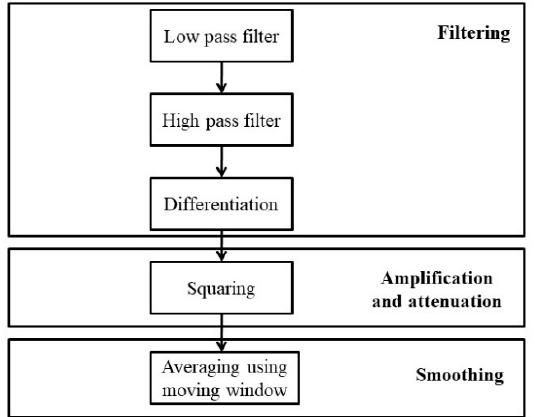
Figure 5. Pan–Tompkins algorithm for filtering ECG signal.